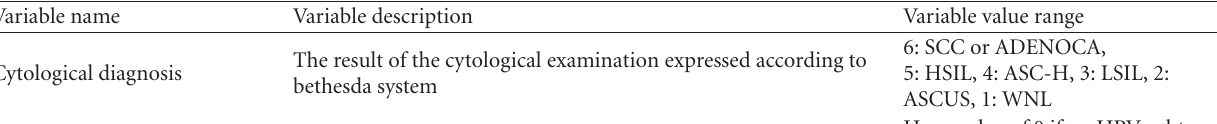
Table 1: Variables used for the training of the LVQ NN classifier.